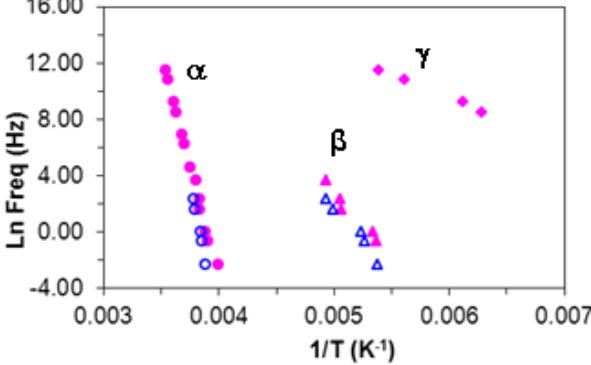
Figure 15. Comparative relaxation map for uncured ELP at 2 K/min obtained by two techniques: DRS, filled pink symbols; and DMA, open blue symbols.